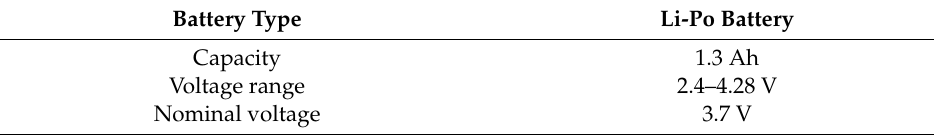
Figure 6. Experimental environment for lithium battery simulation. Table 2. Battery internal resistance used in the